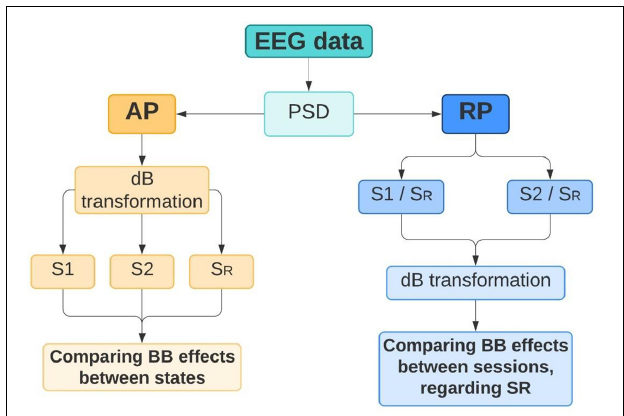
FIGURE 4 | Power spectral density (PSD) analysis. Absolute power (AP) and relative power (RP) were extracted from EEG data in order to identify brain changes that can denote brain